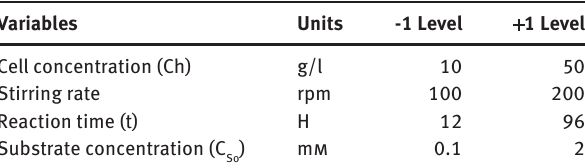
Table 2: Experimental range and of the independent variables. Variables